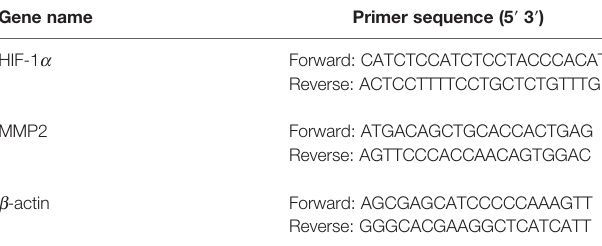
TABLE 2 | Primer sequences used in real-time PCR